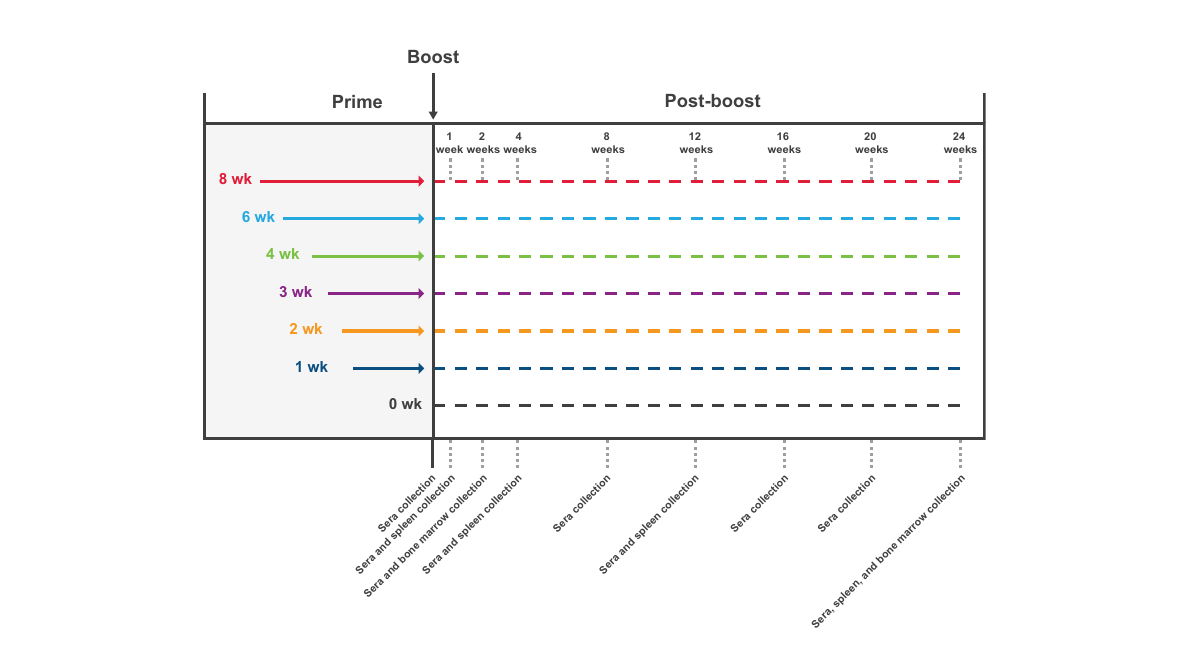
FIGURE 1 Study Design. The impact of the dosing interval on mRNA-1273 vaccine immunogenicity was evaluated by administering 2 doses of mRNA-1273 (1 µg or 10 µg) to mice on a schedule of 1-, 2-, 3-, 4-, 6-, or 8-week intervals between doses; a prime-only group (only administered fi rst dose of mRNA-1273 at time of dose 2) was also evaluated for comparison purposes. Sera were collected from mice (n=8-10 per group) before dose 2 and 1, 2, 4, 8, 12, 16, 20, and 24 weeks following dose 2. Spleens were collected 1, 4, 12, and 24 weeks after dose 2 from a subgroup of mice (n=8-10 per group) administered mRNA-1273 10 µg; bone marrow samples were collected 2 and 24 weeks after dose 2 from the same subgroup of mice. mRNA, messenger